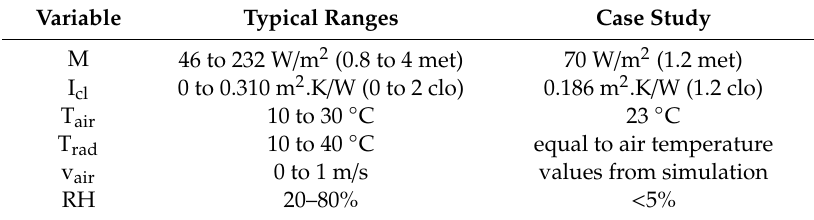
Table 5. PMV index factors overview.